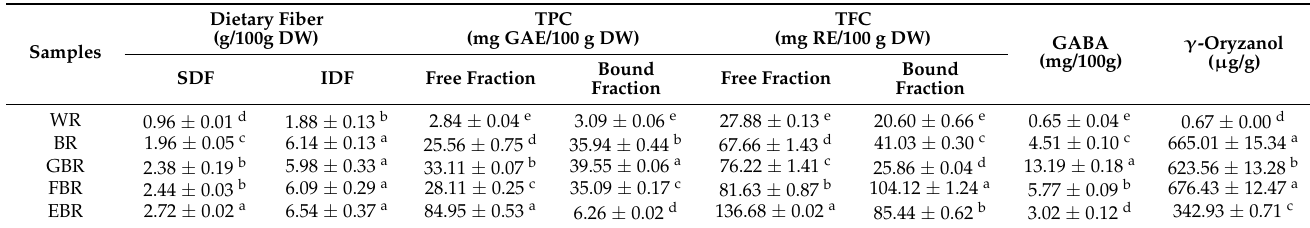
Table 2. The content of bioactive components in different brown rice